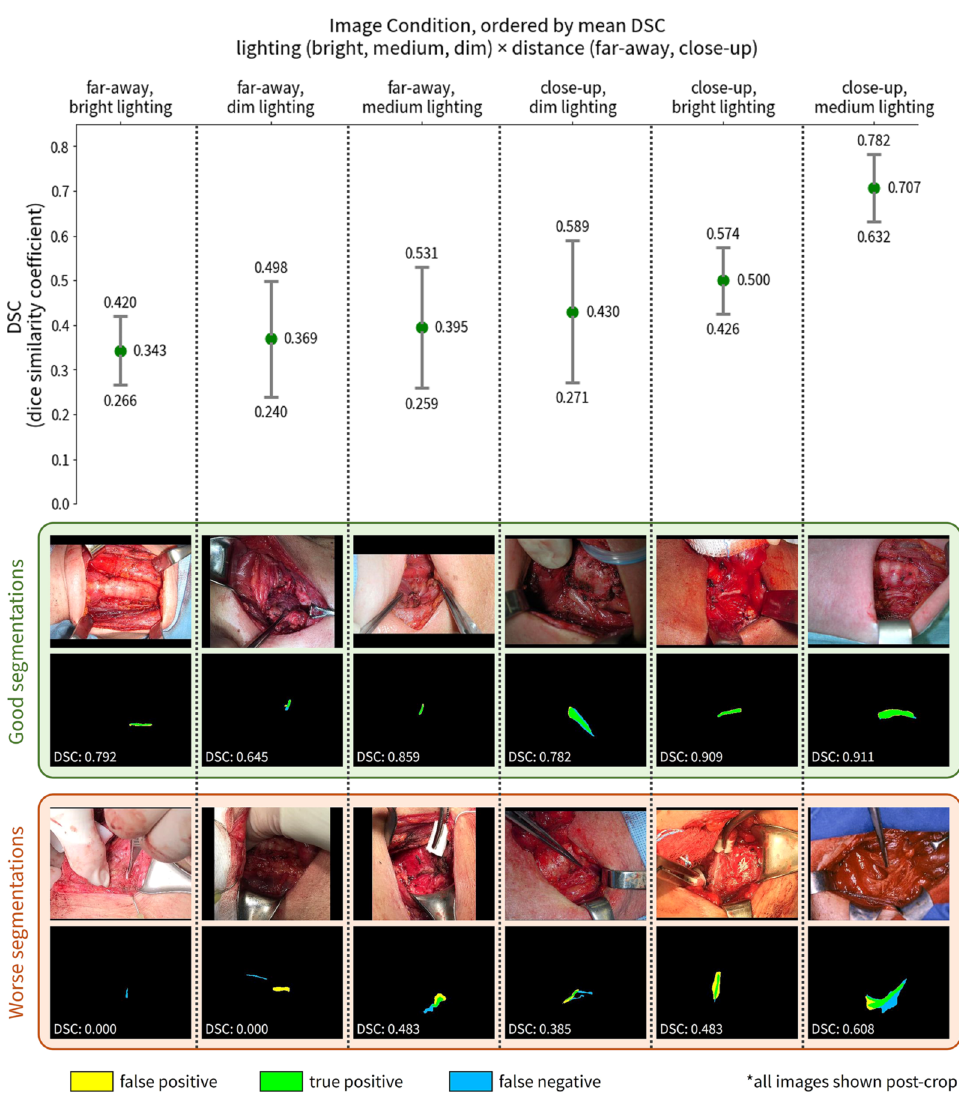
Figure 3. Qualitative nerve segmentation results. Qualitative nerve segmentation results under different image conditions (picture distance and brightness), with summary statistics and example images from all 5 cross- validation test folds. For each of the six image conditions labeled at the top of the figure, we show three results: a plot at the top with the mean DSC scores and 95% confidence intervals (as shown in Table 1), and in the two bottom boxes, corresponding example good (green) and worse (orange) results from each image condition to illustrate the range of model performance. For each vertical image pair in the two bottom boxes, the original image is on top and the overlaid predicted and ground-truth segmentations annotated by surgeons is on the bottom. In the overlaid segmentations, the intersection of the predicted and ground-truth segmentations (true positive) is green, false positive pixels are in yellow, and false negative pixels are in blue. Note that both far- away and close-up images and corresponding segmentations are shown post-crop with the cropping model for better segmentation visualization. In the good segmentation cases, the predicted segmentation masks track closely with the ground-truth and demonstrate successful learning of expected nerve morphology. Furthermore, notice that the algorithm performs well even in difficult scenarios such as very thin nerves (e.g. far-away, bright lighting), small nerves (far-away, medium lighting), and boundary details (close-up, dim lighting; close-up, medium lighting). The worse segmentation cases highlight challenging scenarios for the model, such as missing very small nerves (far-away, bright lighting), anatomies in better-lit portions distracting from a poorly-lit nerve (far-away, dim lighting), artifacts due to neighboring tissue texture (far-away, medium lighting), difficulty with irregular nerve shapes that deviate from more common, smooth nerve morphologies in the dataset (close-up, dim lighting; close-up, medium lighting), and light reflectance on the nerve leading to over-segmentation (close-up, bright lighting). The worse cases occur more frequently and severely in poorer distance and lighting conditions. These cases illustrate that capturing higher-quality images with respect to both picture distance and brightness is important for achieving better segmentation performance. Best viewed in